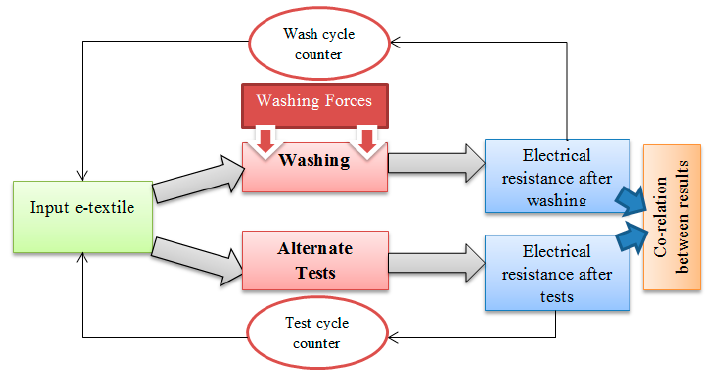
Figure 1. Experimental approach.